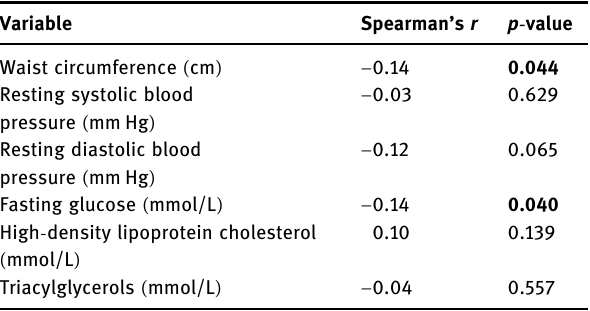
Table 3: Correlations between subjectively perceived social support level and criteria of metabolic